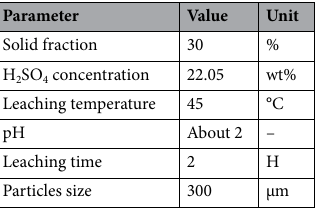
Table 4. Optimum conditions of the leaching experiments.